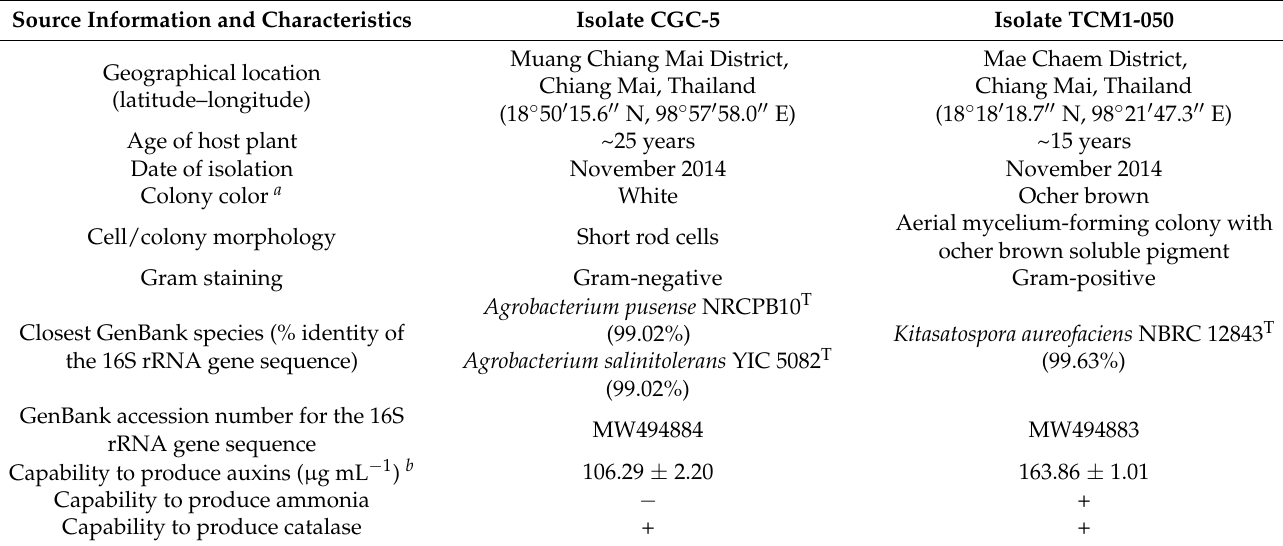
Table 1. Teak-derived rhizobacteria used in this